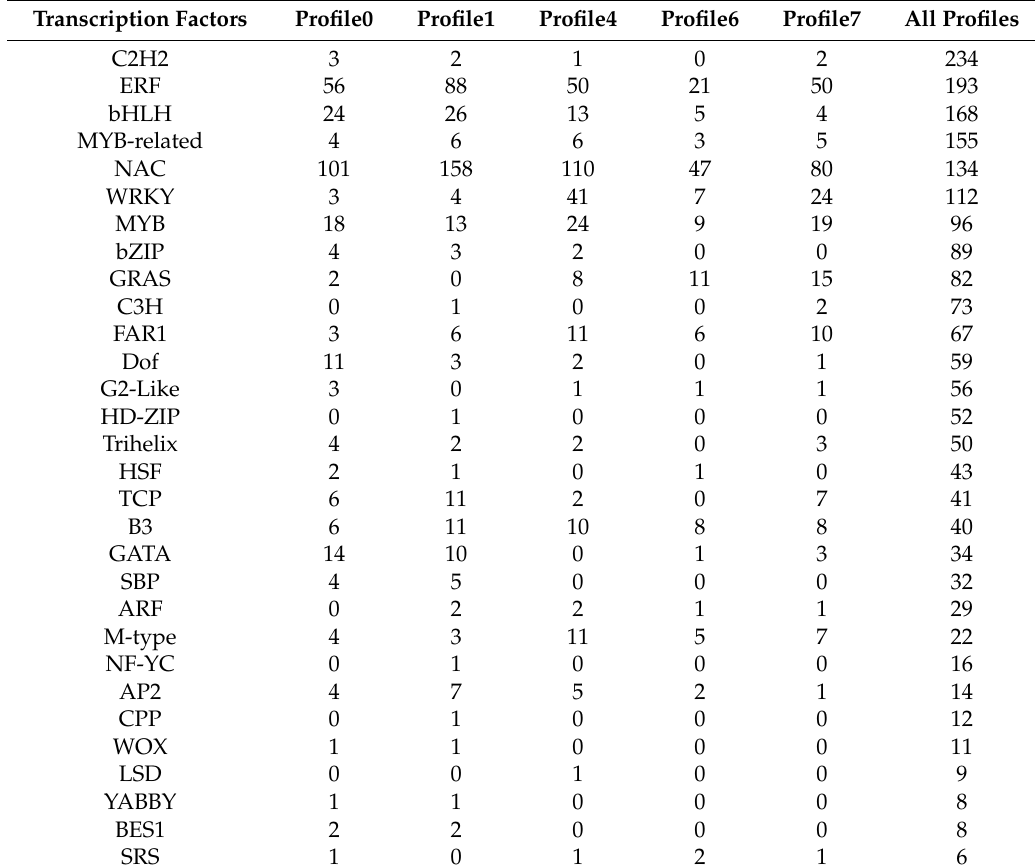
Table 4. The number of the transcription factors identified in the expression